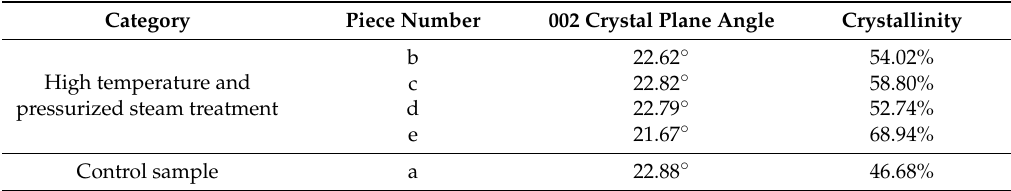
Table 8. Comparison of the crystal properties and degrees of crystallinity of the unmodified and modified wood fibers.